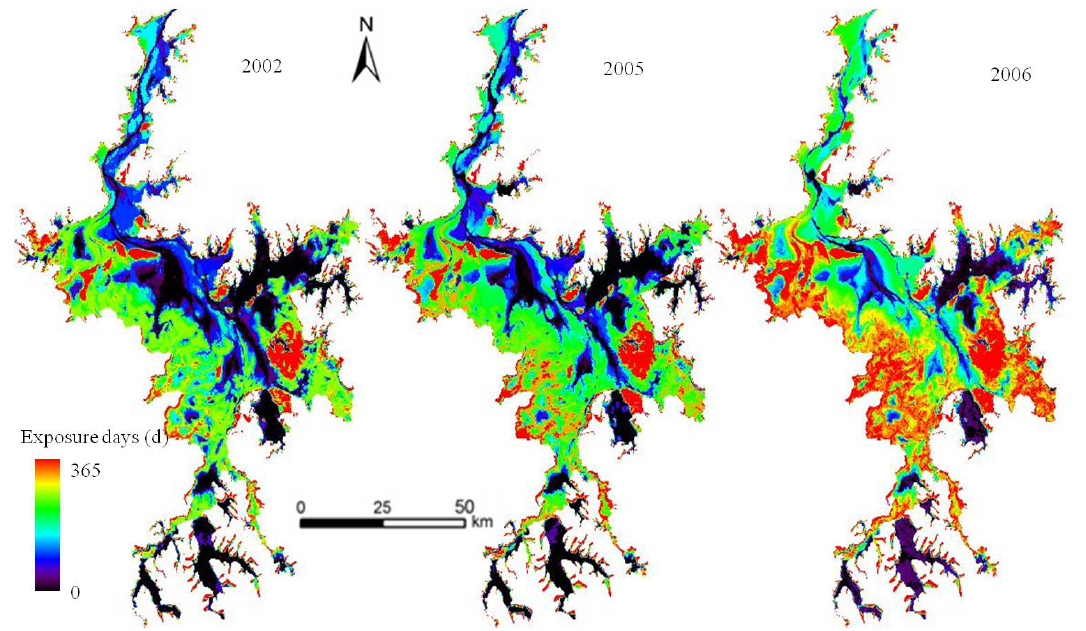
Figure 4. Spatial distribution of exposure days in the Poyang Lake wetland in 2002, 2005, and